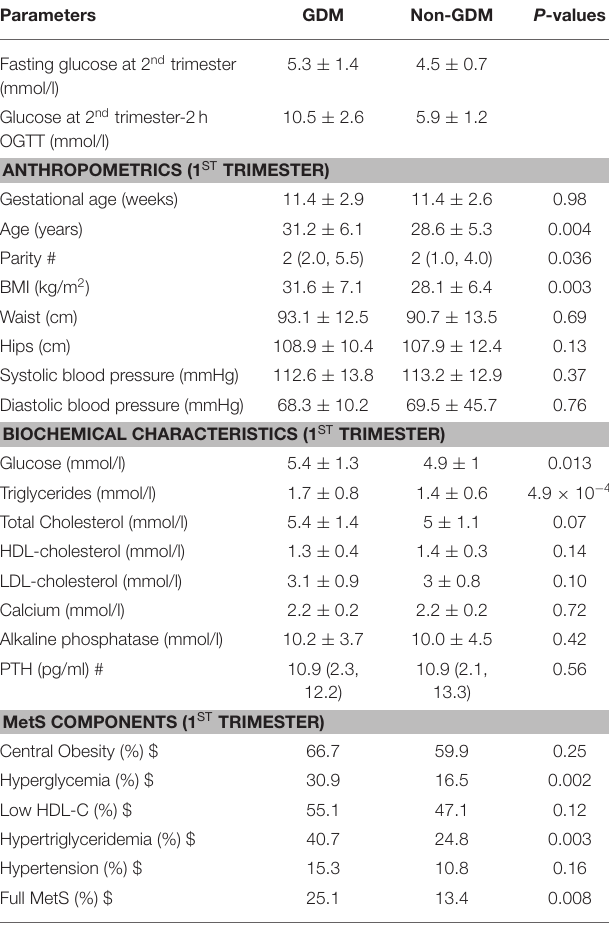
TABLE 1 | Biochemical characteristics and incidence of MetS components at 1st